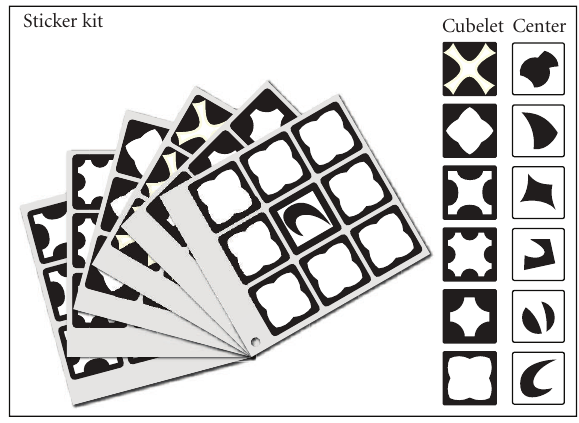
Figure 4: The OOTC sticker